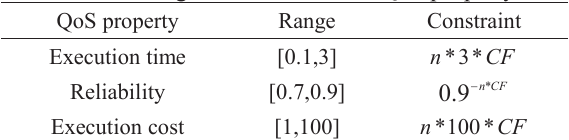
Table 3 Range and constraint of QoS property